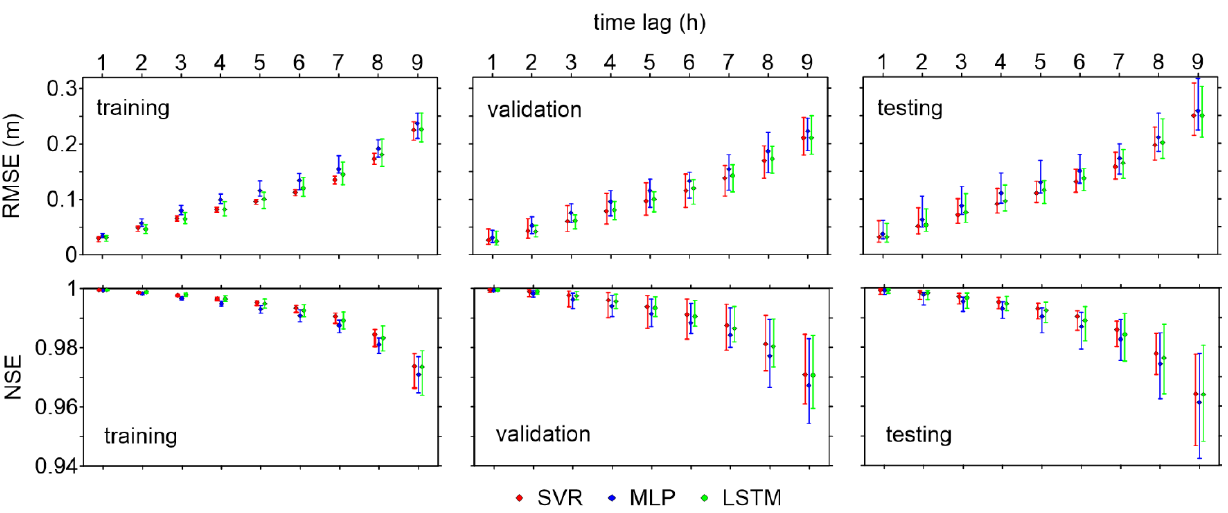
Figure 6. Examples of error metrics (RMSE and NSE) for all forecast horizons (1–9 h). Vertical bars indicate the range of variability of the error metrics for 20 different train/validation/test splits. Symbols corresponding to different models (SVR, MLP, and LSTM) are slightly unaligned to improve readability.